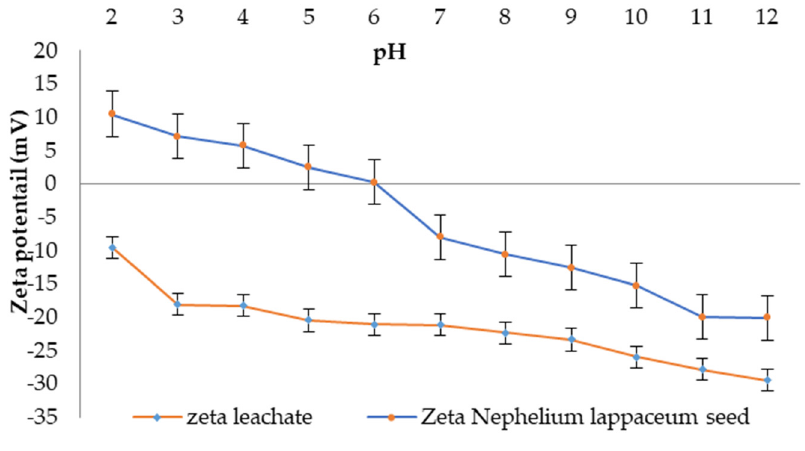
Figure 5. pH effect on Zeta potential of leachate.